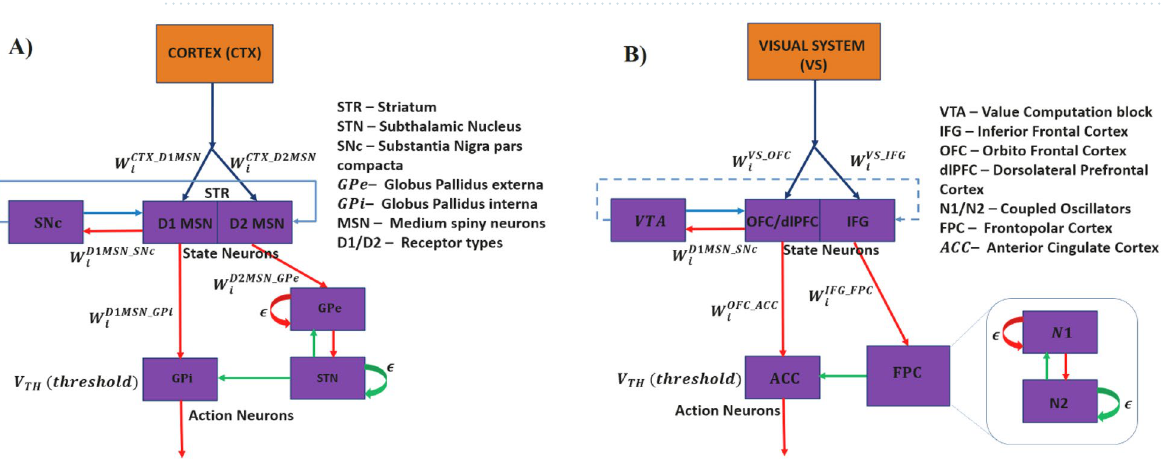
Figure 7. Biological Representation of GRLDNN Agent Model inspired by ( A ) Basal Ganglia (BG) architecture and ( B ) the equivalent representation of prefrontal cortex (PFC) Architecture. SNc, Substantia Nigra pars compacta; STR, Striatum; GPi, Globus Pallidus interna; GPe, Globus Pallidus externa; STN, Subthalamic Nucleus; MSN, Medium Spiny neurons; STN-GPe forms a coupled oscillator system with interconnectivity weights W between STN and GPe and ǫ is the lateral connection strengths among the neurons of STN and GPe. Action is selected based on the winner neuron crossing the threshold (V TH ) first. VTA, ventral tegmental area; OFC, Orbitofrontal cortex; DLPFC, dorsolateral prefrontal cortex; IFG, inferior frontal gyrus; FPC, frontopolar cortex; ACC, anterior cingulate cortex; FPC is modeled using a coupled oscillator system with interconnectivity weights W between oscillators N1 and N2 and ǫ is the lateral connection strengths among the neurons of N2. OFC/DLPFC to ACC weights are updated using